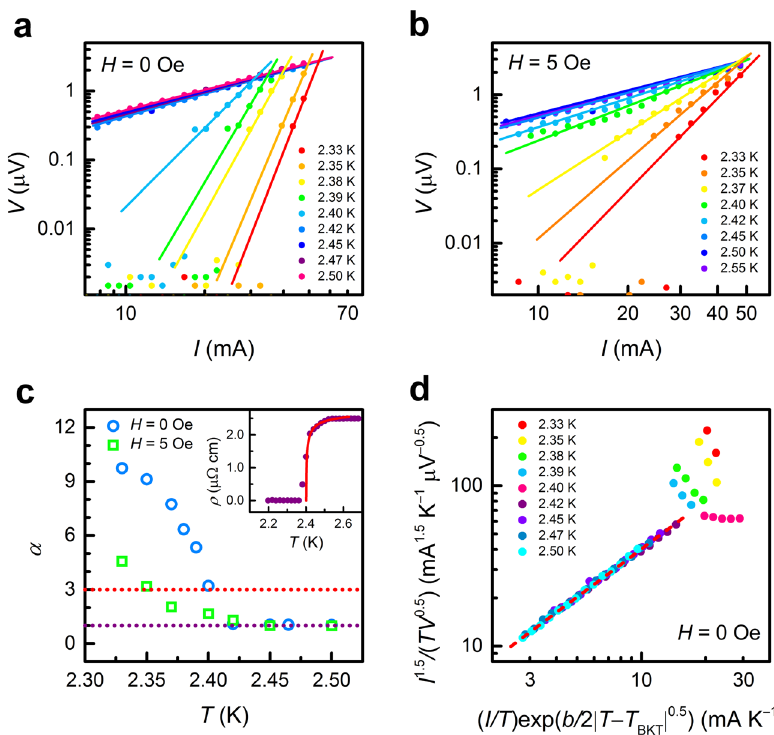
Fig. 5 BKT nature of AuSn 4 . I – V isotherms of an AuSn 4 single crystal on a ln – ln scale with: a a zero fi eld and b an applied fi eld of 5 Oe. The straight lines are power-law fi ts to the data at different temperatures. c Temperature dependence of the power-law exponent α deduced from the power-law fi ts in a and b . Dashed lines denote the α values of 3 (red) and 1 (purple), respectively. The inset shows the ρ – T curve near the T BKT regime that can be well fi tted with (cid:7) (cid:8) 1 = 2 as a function of the scaling function variable I ξ HN relation, as illustrated by the solid line. d Scaled plot of I T I V T for data in a . The dashed line represents the best collapse onto a scaling curve at temperatures above T BKT